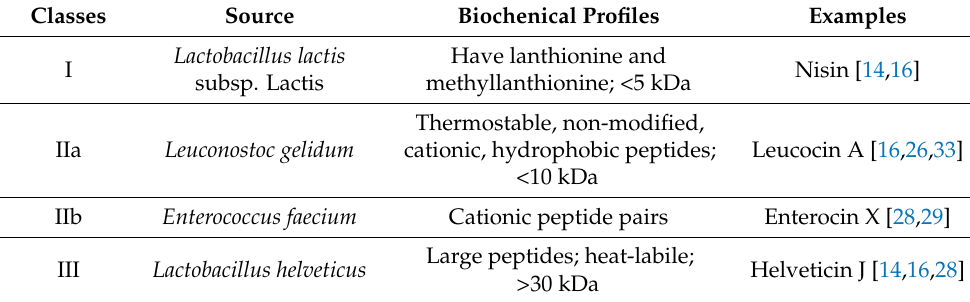
Table 1. Classification and properties of LAB